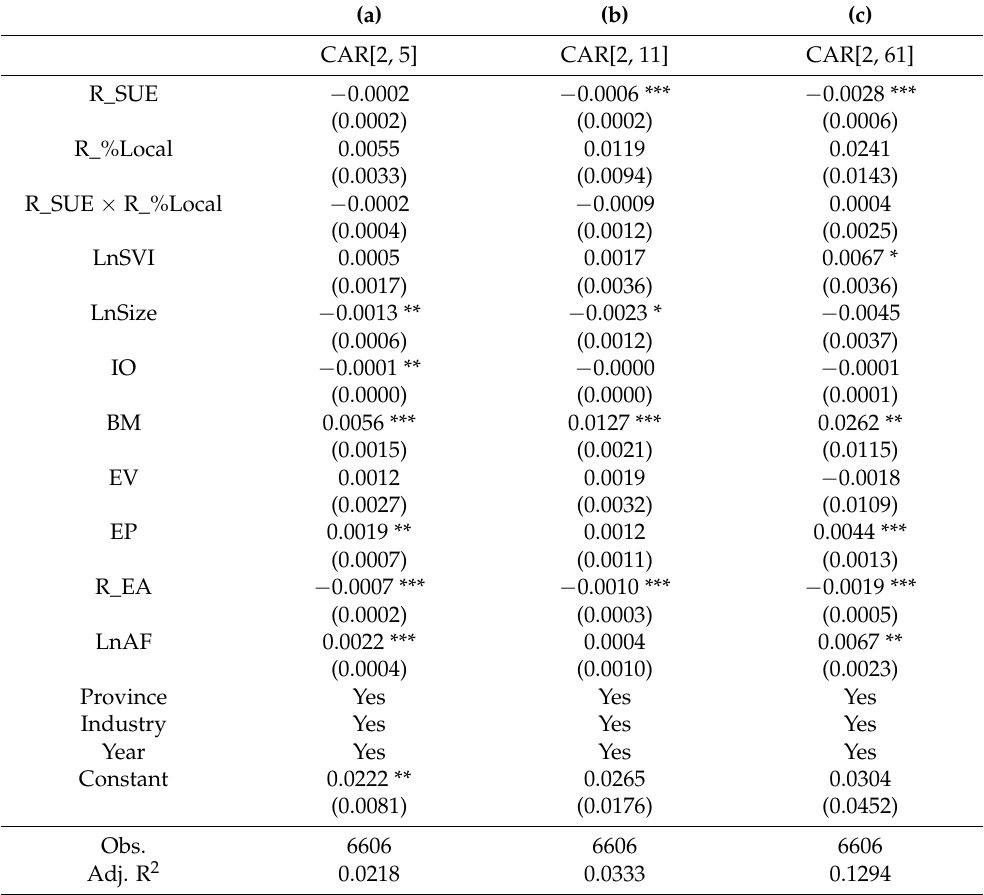
Table 12. Local Attention and Post-Earnings Drift in Different Length of Event Windows.